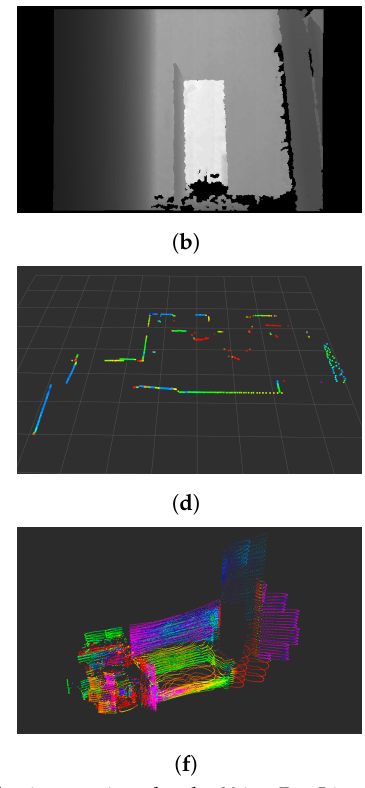
Figure 1. Information given by different types of sensors: ( a ) color image given by the Xtion Pro Live camera; ( b ) depth image given by the Xtion Pro Live camera; ( c ) point-cloud obtained from the color and depth image given by the Xtion Pro Live camera; ( d ) information given by a 2D LiDAR (scan topic from the Velodyne_pointcloud package using a Velodyne VLP-16); ( e ) information given by a 3D LiDAR (point-cloud topic from the Velodyne_pointcloud package using a Velodyne VLP-16); and ( f ) information given by a solid-state LiDAR (Livox